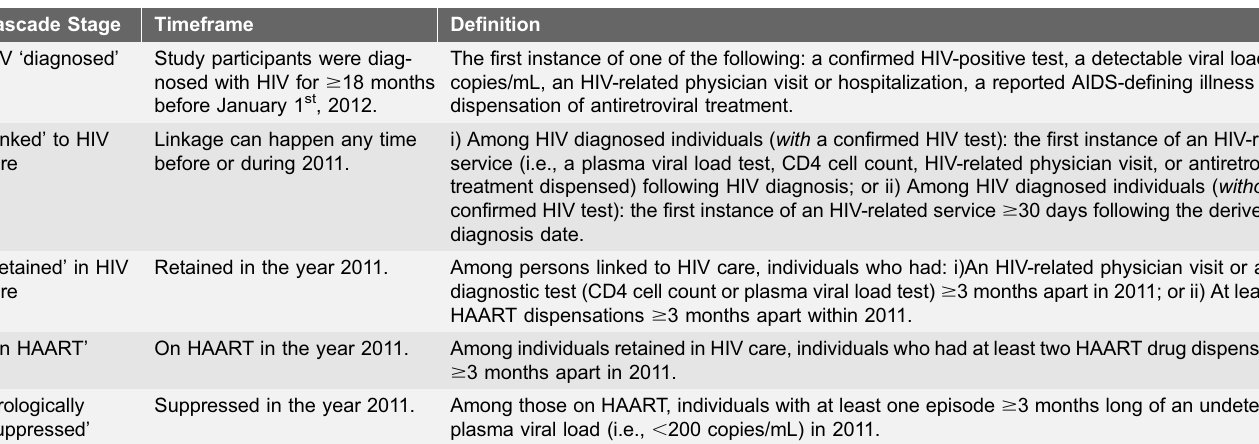
Table 1. HIV Cascade of Care